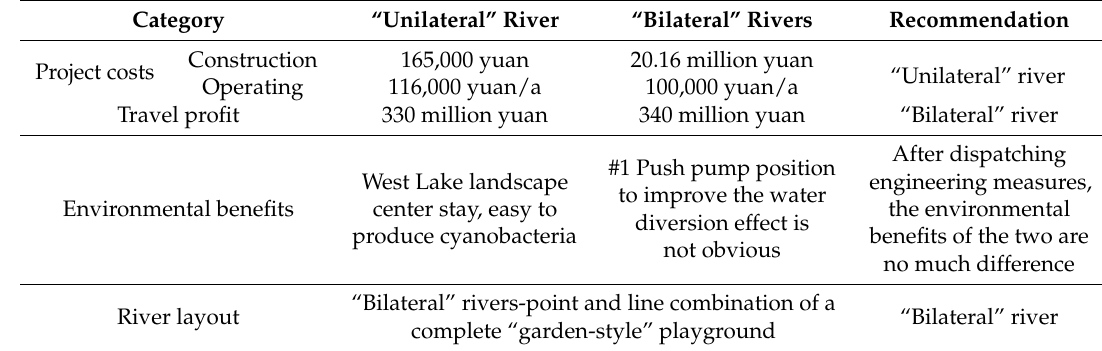
Table 8. Comparison of comprehensive benefits of “unilateral” and “bilateral”